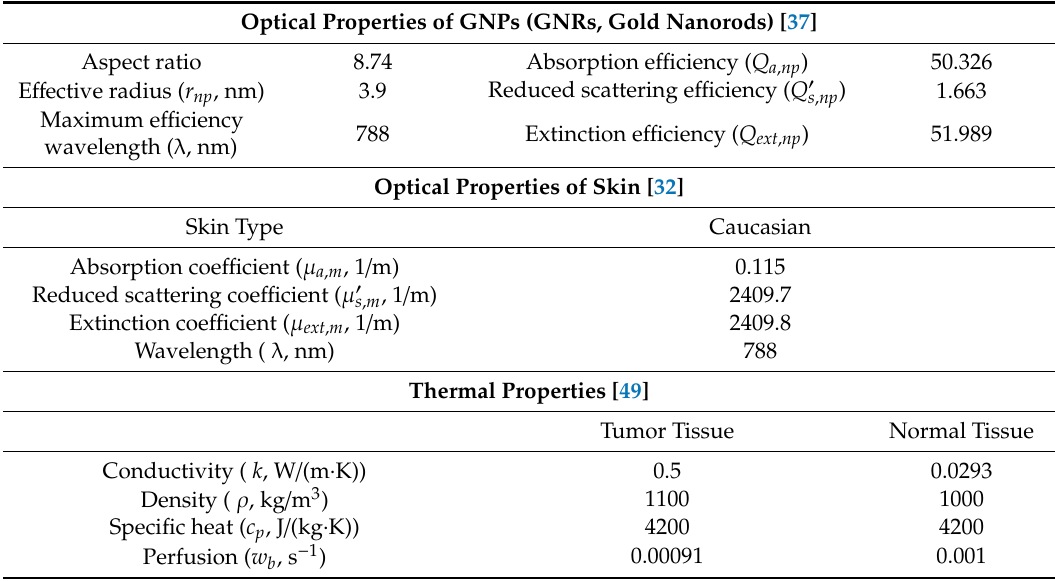
Table 3. Properties evaluated in the numerical